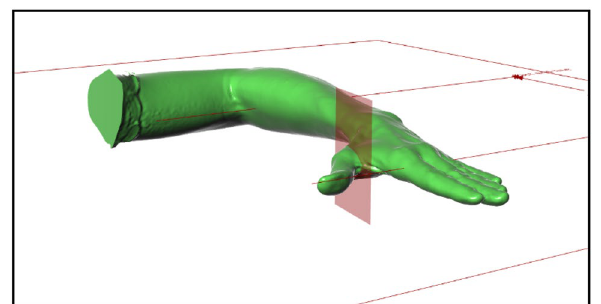
Fig. 6 Thumb cut plane positioning